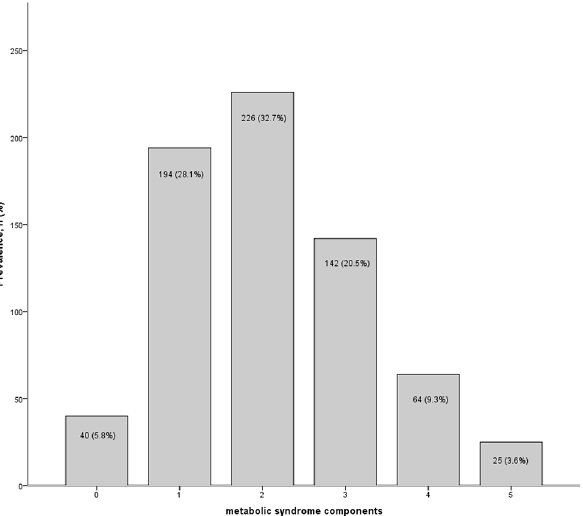
Fig 2. Proportion of study participants with specific number of components of the metabolic syndrome.